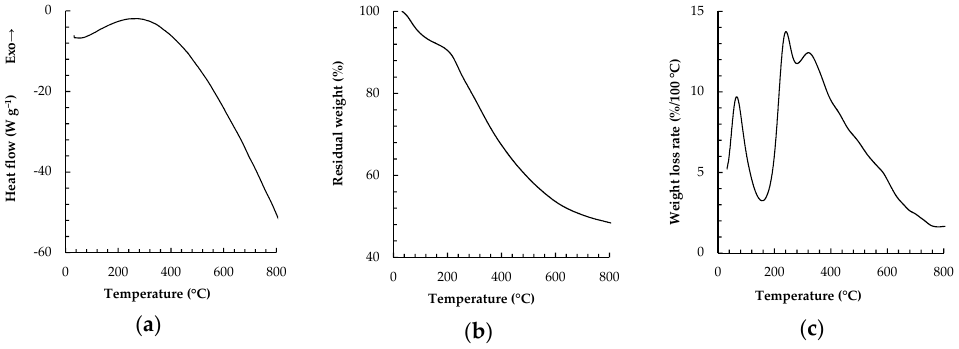
Figure 1. ( a ) Differential scanning calorimeter; ( b ) thermal gravimetry; and ( c ) differential thermal gravimetry of chestnut shell pigment (CSP).